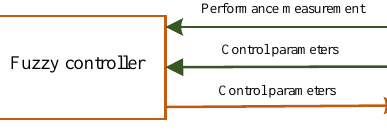
Figure 2. FAGA basic schematic